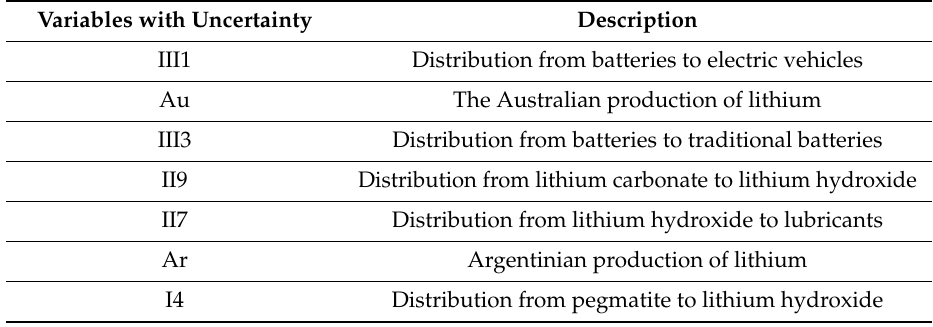
Table 5. Selected variables with the greatest relevance to the future production of electric